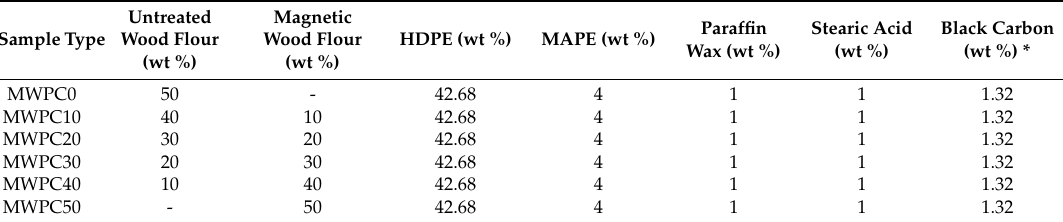
Table 1. Formulations of biocomposites for